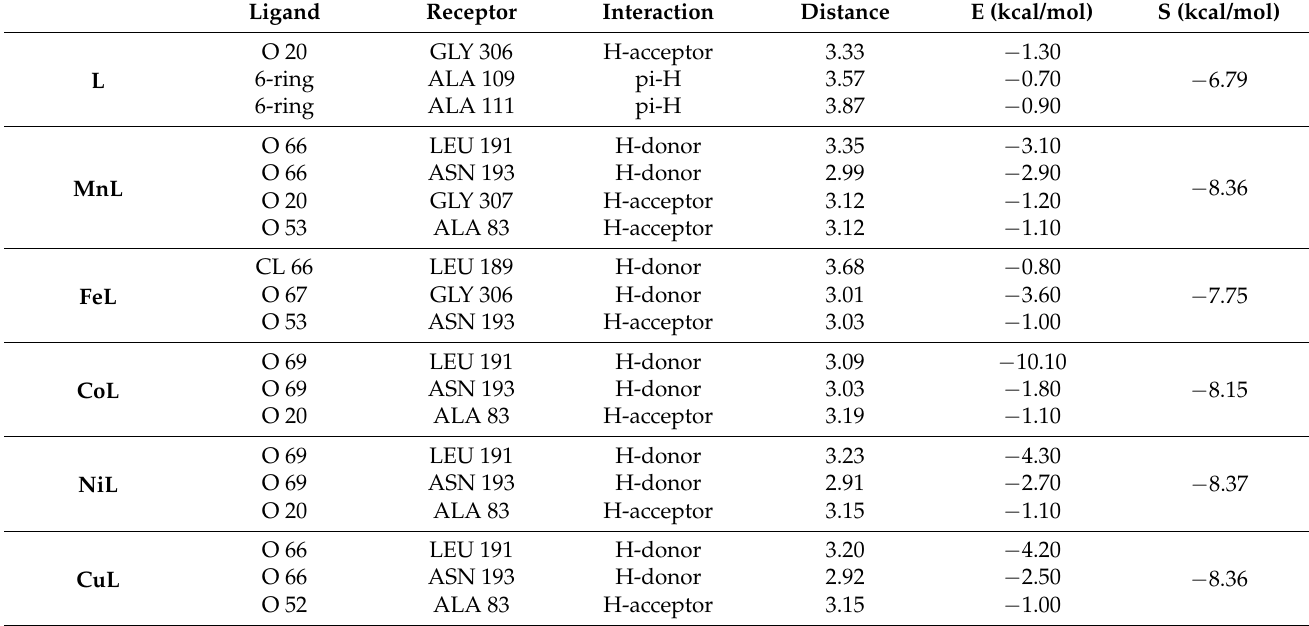
Figure 5. 3D orientation of the substrate-protein complex. Table 5. molecular docking data.